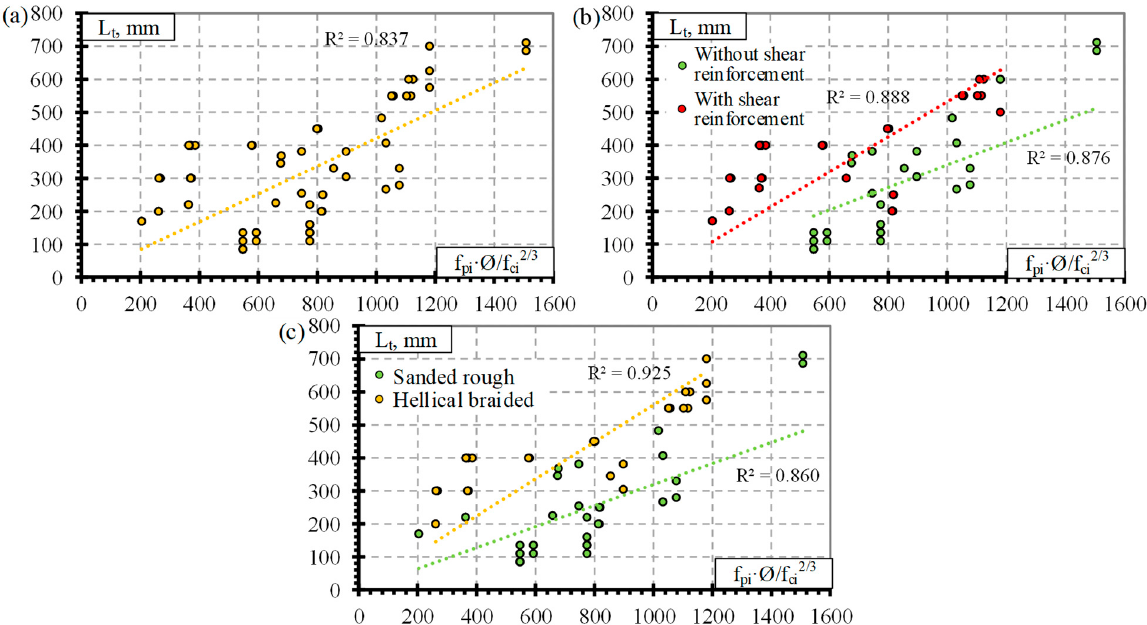
Figure 5. Relationship between transfer length of CFRP bars and f pi · Ø/f 2/3 effect of type of prestressing transfer, ( c ) effect of shear reinforcement, ( d ) effect of reinforcement surface conditions.